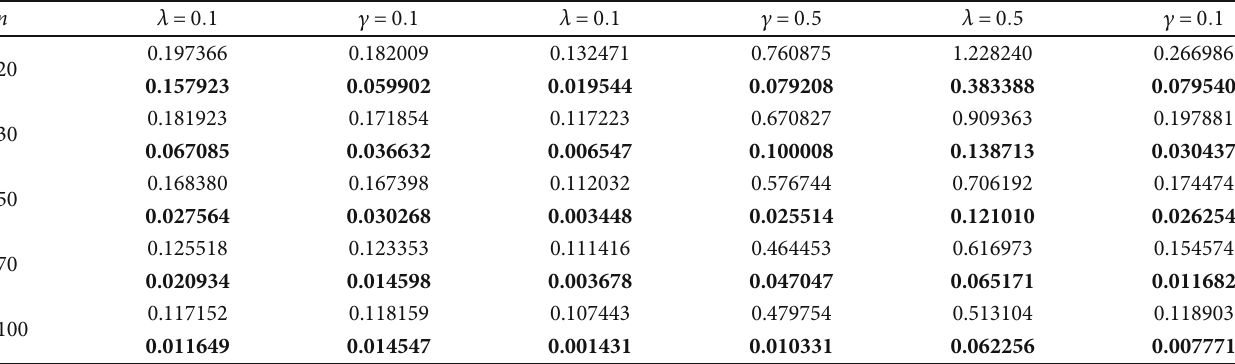
Table 2: BEs and PRs under PLF and noninformative prior using λ = 0 : 1, 0 : 5 and γ = 0 : 1, 0 : 5 .